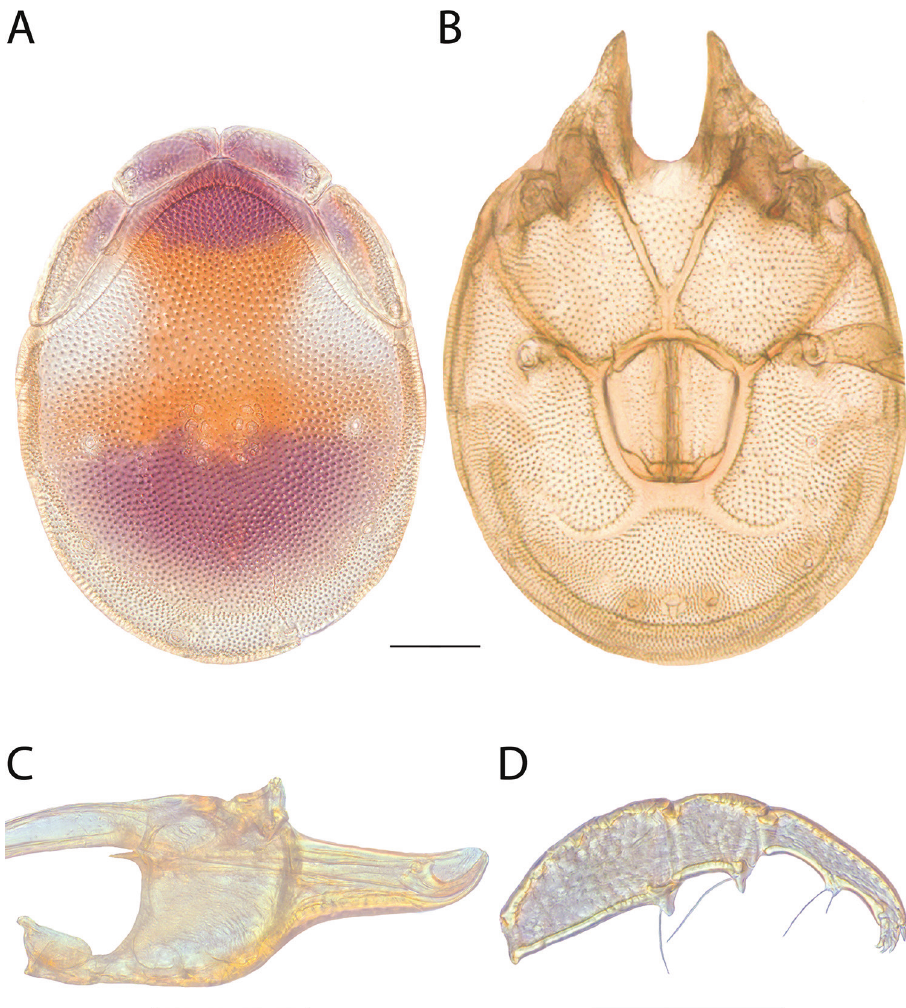
Figure 100. Torrenticola interiorensis sp. n. female: A dorsal plates B venter (legs removed) C subcapitulum D pedipalp (setae not accurately depicted). Scale = 100